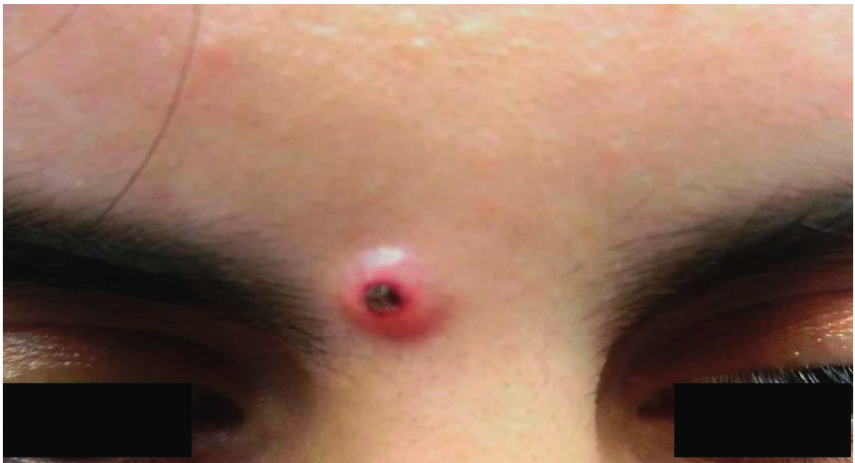
Figure 1: Clinical photograph of an indolent, asymptomatic nodule on the forehead.